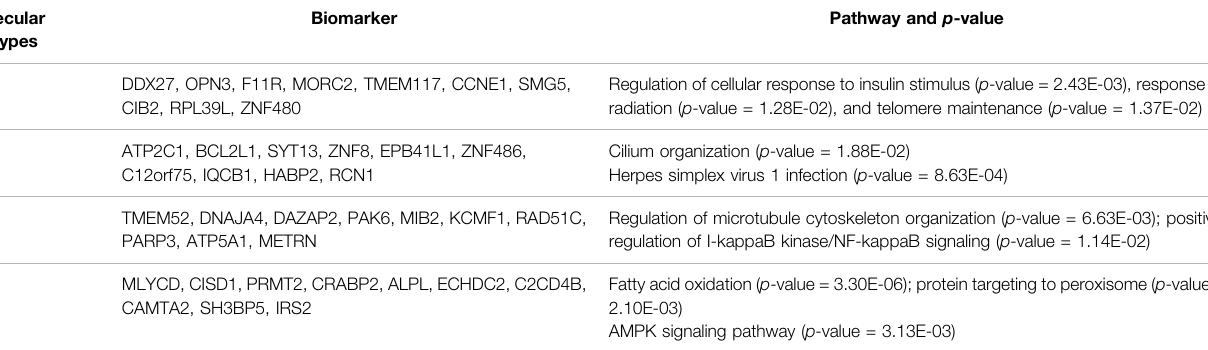
TABLE 5 | Speci fi c biomarkers of each STAD subtype and their enrichment pathways. The listed biomarkers rank in descending order from high to low speci fi c score. Molecular Biomarker Pathway and p subtypes